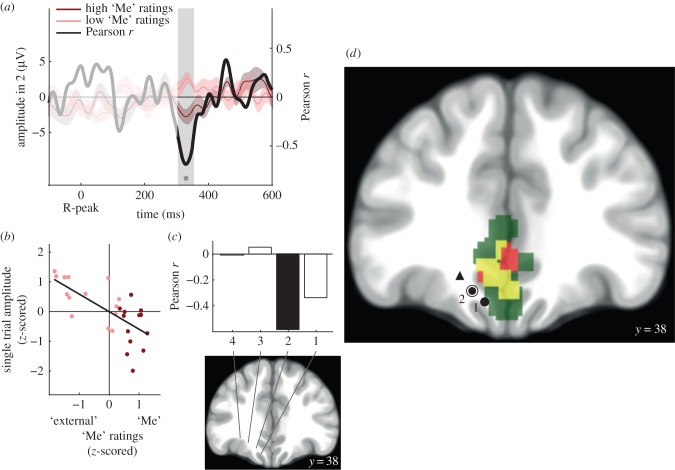
The trial-by-trial amplitude of HERs in the vmPFC correlates with the involvement of the ‘Me’ in spontaneous thoughts (patient 1). (a) Time course of the Pearson correlation coefficient r between the trial-by-trial HER amplitude and the ratings on the ‘Me’ scale (black), and HERs (±s.e.m.) for ‘high’ (dark red) and ‘low’ (light pink) ratings on the ‘Me’ scale (median split of ratings), for recording site 2 (circled dot in (d)). The signal that might be residually contaminated by the cardiac-field artefact appears in lighter colour (not included in the analysis). The grey area highlights the time window in which a significant trial-by-trial correlation between HER amplitude and ‘Me’ ratings was observed. (b) HER amplitude in the significant time window plotted against ‘Me’ ratings. Each point represents one trial. (c) Mean Pearson correlation coefficient in the 304–354 ms time window, along the different recording sites of the electrode shaft of patient 1. The black bar corresponds to the recording site for which a significant correlation was found. (d) Differential HERs, sympathetic regulation and vmPFC. Recording site 2 (circled dot) showed the significant correlation, while recording site 1 and the triangle (patient 2) showed no effect. Regions in red showed differential responses to heartbeats along the ‘Me’ scale, in a previous MEG study [25]. Regions in green are involved in sympathetic regulation [34]. Yellow corresponds to the overlap between MEG results and sympathetic regulation regions.